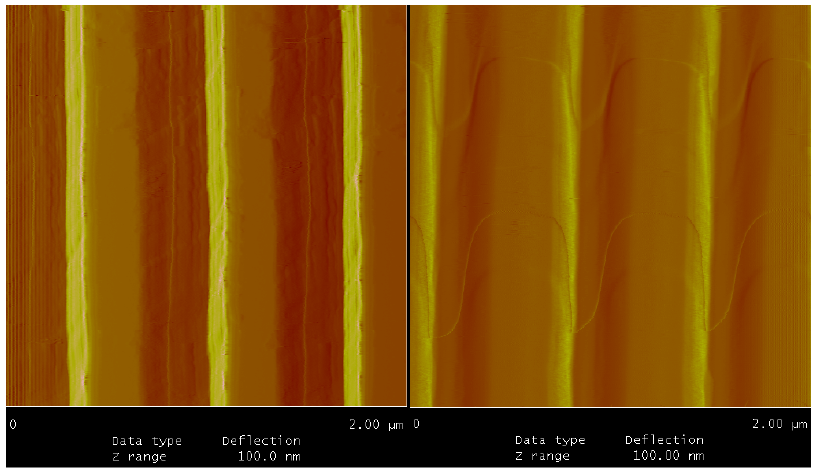
Figure 5. AFM images of grating surface before and after